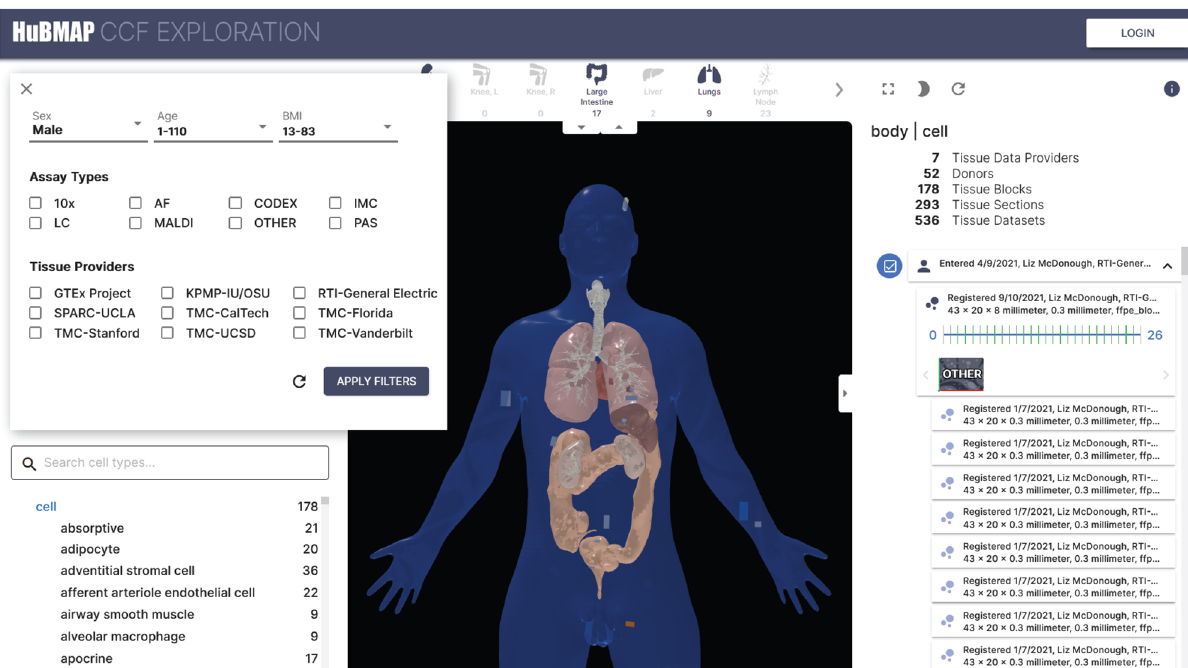
Fig. 2 Tissue Exploration User Interface (EUI). The EUI features an anatomical structure “ partonomy ” on top left (occluded by fi lter menu, but see Fig. 3c) and a listing of unique cell types in lower left; 3D reference organs with registered tissue blocks (in white) and one selected skin tissue block in upper left leg (in orange) in middle; and details on all fi ltered tissue blocks, sections, and datasets on right – the selected skin tissue block has 26 tissue sections, each section has associated datasets. Filters for specimen metadata are provided in top left (sex, age, BMI, assay types, tissue providers). They are accessible via a fi lter menu; fi lter for sex has been set to 'Male.' Registered tissue blocks can be explored via specimen data, biological structure terms, or spatially using the 3D reference organ framework.